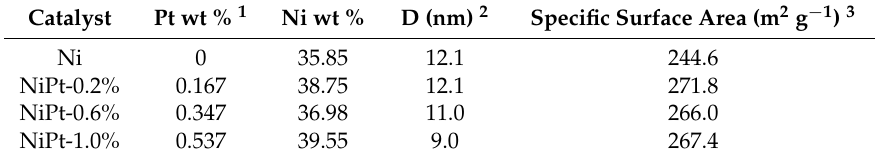
Table 1. Metal loadings, sizes and specific surface areas of the supported